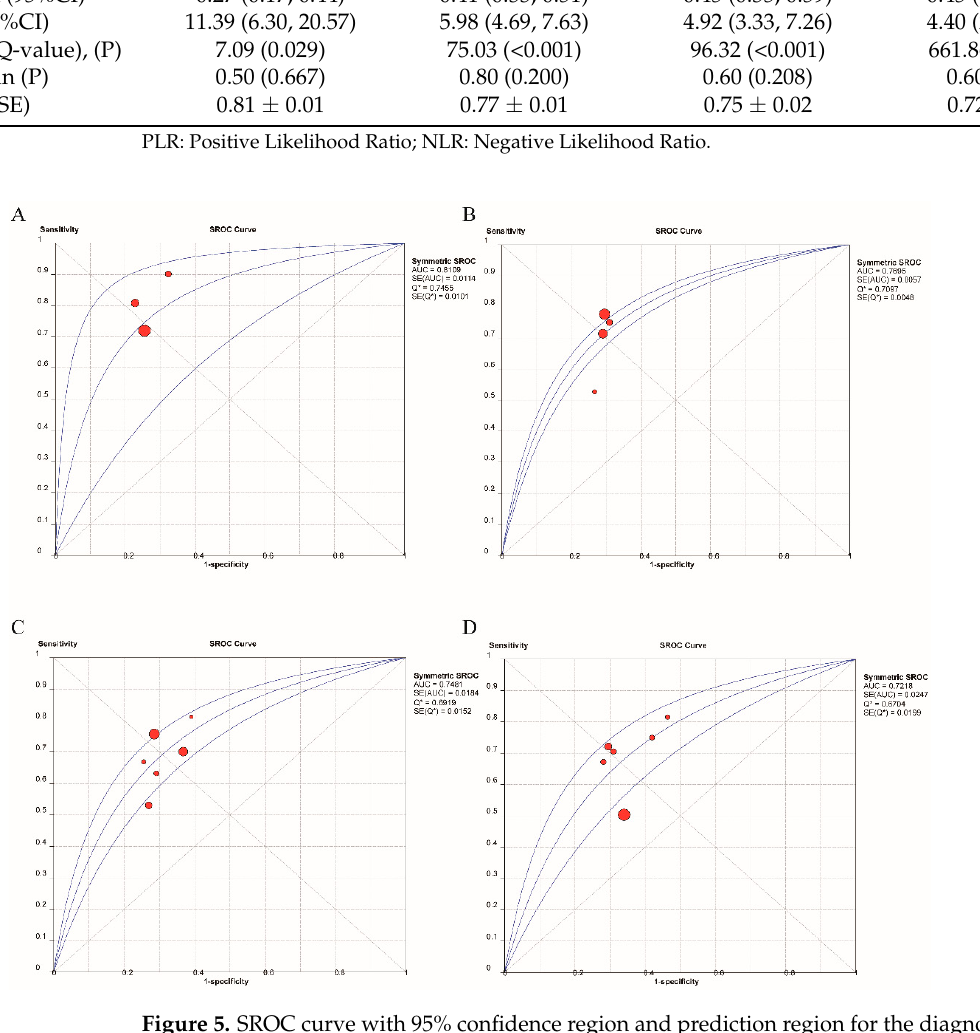
Table 3. Summary diagnostic accuracy at Various Diagnostic Parameters for Diagnosis and Predic ‐ tion for MAFLD.